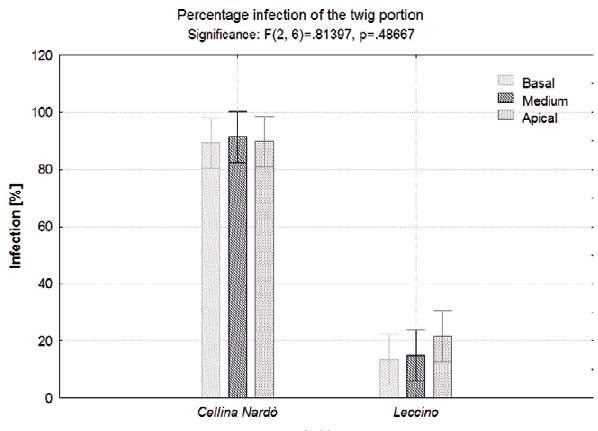
Figure 3. Mean infection rates for diff erent olive twig portions (basal, middle, apical) for the Xylella fastidiosa tolerant ‘Leccino’ and the susceptible ‘Cellina di Nardò’ cultivars.